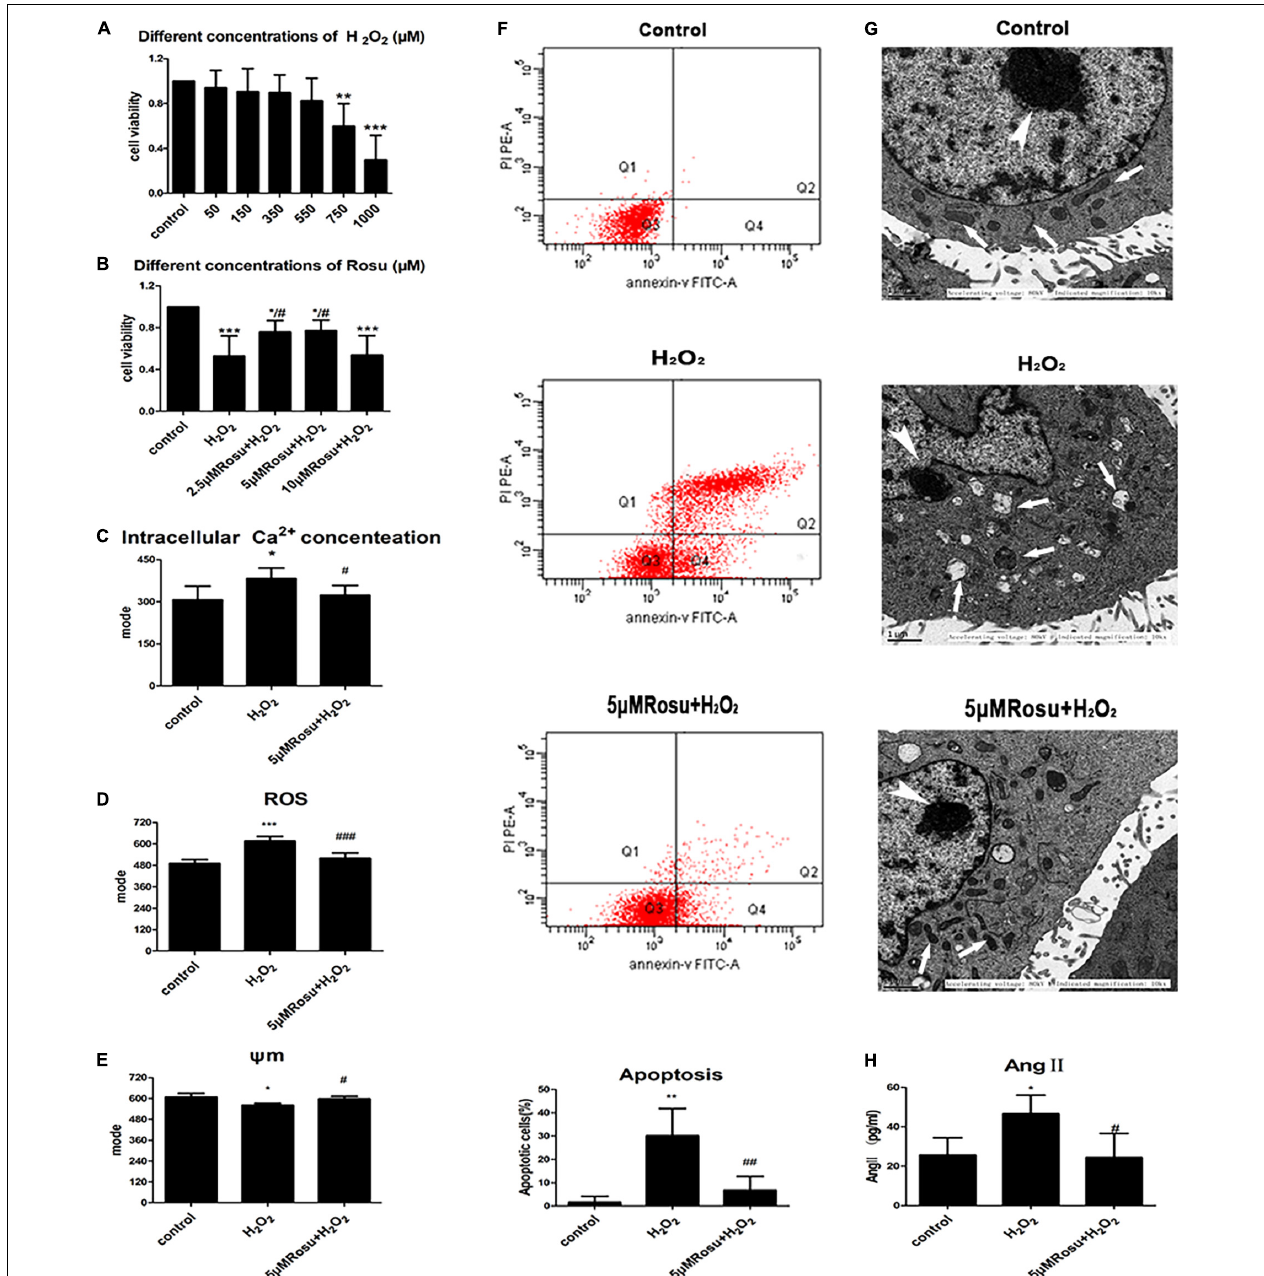
FIGURE 5 | Rosuvastatin intervention promotes mitochondrial function and reduces apoptotic cells from H 2 O 2 -induced human umbilical vein endothelial cells (HUVECs) injury. (A) HUVECs viability was reduced when exposed to H 2 O 2 (750/1,000 µ M, 24 h). (B) Rosuvastatin (pretreatment 2 h, 2.5/5 µ M) protected cells from H 2 O 2 -induced injury in HUVECs. (C–F) H 2 O 2 -induced endothelial injury caused an increase in intracellular free Ca 2 + (C) , and the release of ROS (D) , reduction of (cid:49)(cid:57) m (E) , apoptotic cell augmentation (F) , and mitochondrial damage when compared to the control group. Rosuvastatin pretreatment was able to reduce the number of apoptotic cells, maintain (cid:49)(cid:57) m, reduce the store of intracellular free Ca 2 + as well as ROS production and protect against H 2 O 2 -induced endothelial injury simultaneously. (G) Ultrastructural changes of endothelial cells in different groups. A structured endothelial cell with normal morphology in the control group, including an evident nucleolus (thick arrow) and an intact nuclear membrane, cytoplasmic mitochondria (thin arrow), and endoplasmic reticulum (thin arrow). Dilated mitochondria (thin arrow), many folds in the nuclear membrane, and the exposed nucleolus (thick arrow) are shown in the H 2 O 2 -induced injury group. Through rosuvastatin pretreating, the cell morphology seemed to be recovering, with the nucleolus less damaged (thick arrow), the nuclear membrane damage being relatively minor, and with reduction in mitochondrial swelling (thin arrow). (H) The concentration of Ang II in different cell groups. Data are shown as mean ± SD of at least three independent experiments. The significance of the four quadrants represented in the picture of apoptosis: Q1 represents the necrotic cells, Q2 represents the late apoptotic cells, Q3 represents the normal cells, and Q4 represents the early apoptotic cells. We counted the total number of Q2+Q4 as the apoptotic cells. * P < 0.05, ** P < 0.01, *** P < 0.001 versus vehicle control; # P < 0.05, ## P < 0.01, ### P < 0.001 versus vehicle H 2 O 2 group, one-way ANOVA.